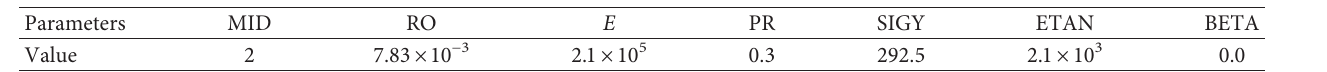
Table 6: Parameters of ∗ MAT_PLASTIC_KINEMATIC (card1).